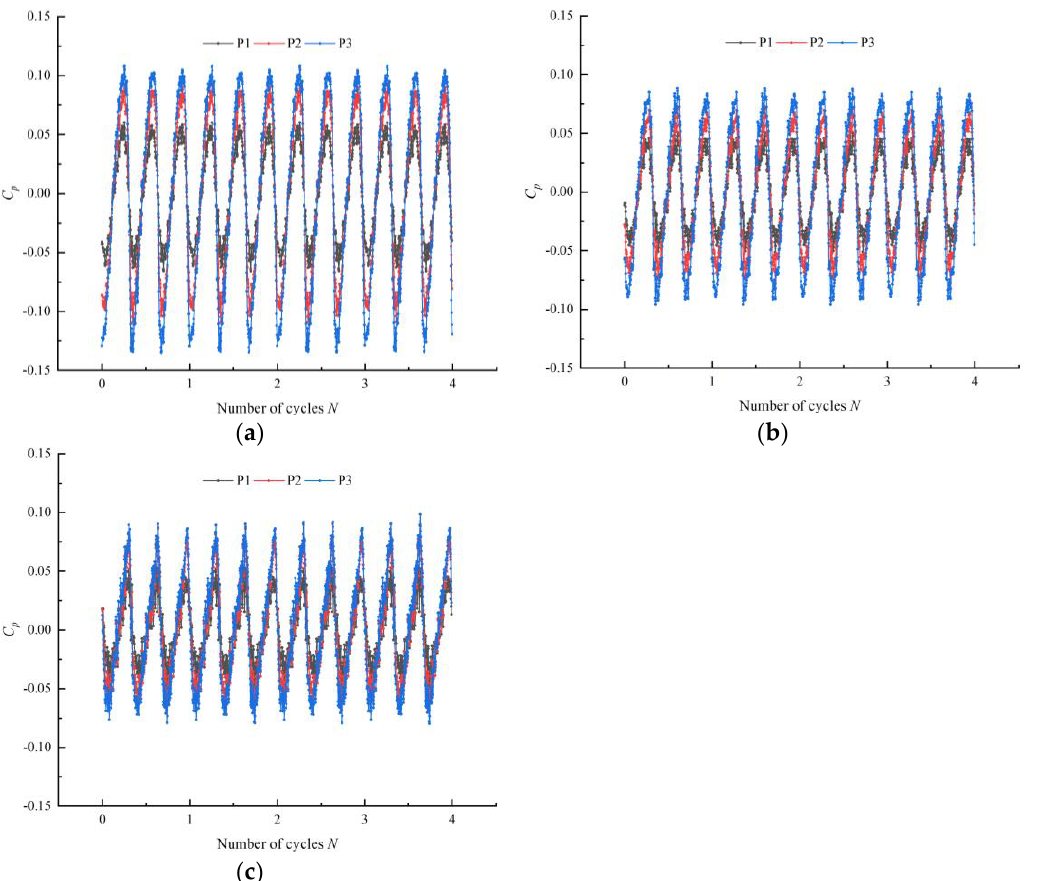
Figure 16. Time domain diagram of C p at impeller inlet: ( a ) Q = 0.8 Q bep ; ( b ) Q = 1.0 Q bep ; ( c ) Q = 1.2 Q bep .